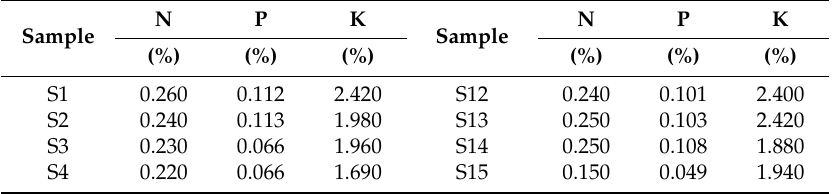
Table 1. Measured concentrations of total N, P, and K in reservoir